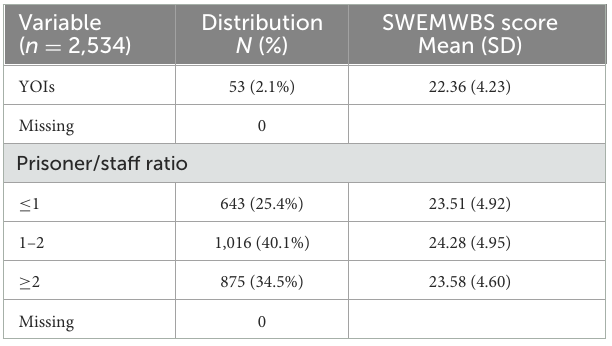
∗ Groupedintoanonymisedregionstoprotectidentity. BMI,bodymassindex;IMD,indexofmultipledeprivation;HMPPS,HerMajesty’sPrisonand ProbationService;SD,standarddeviation;YOI,YoungOffenderInstitutions.